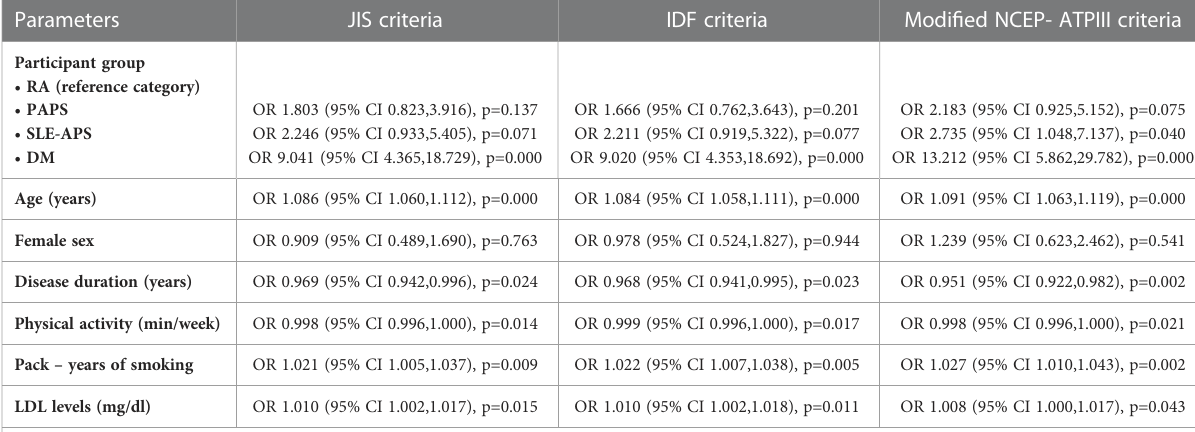
TABLE 3 Disease conferred risk for the presence of metabolic syndrome in patients with PAPS, SLE-APS and DM based on JIS, IDF and modi fi ed NCEP-ATPIII criteria (in multivariate regression models). Parameters